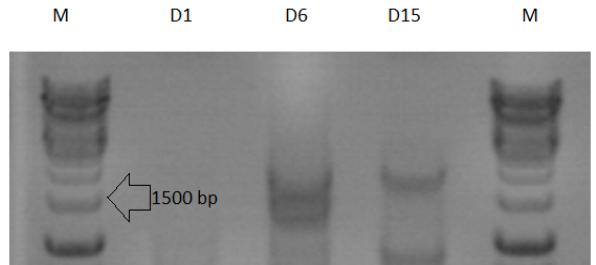
Fig. 2. PCR amplification of Pl 5 with the expected size of 1,500 bp (as indicated by arrow) using Hap3 primer pairs in D1, D6 and D15 differential lines. The D6 and D15 differential lines showed the expected band. M: 1Kb marker